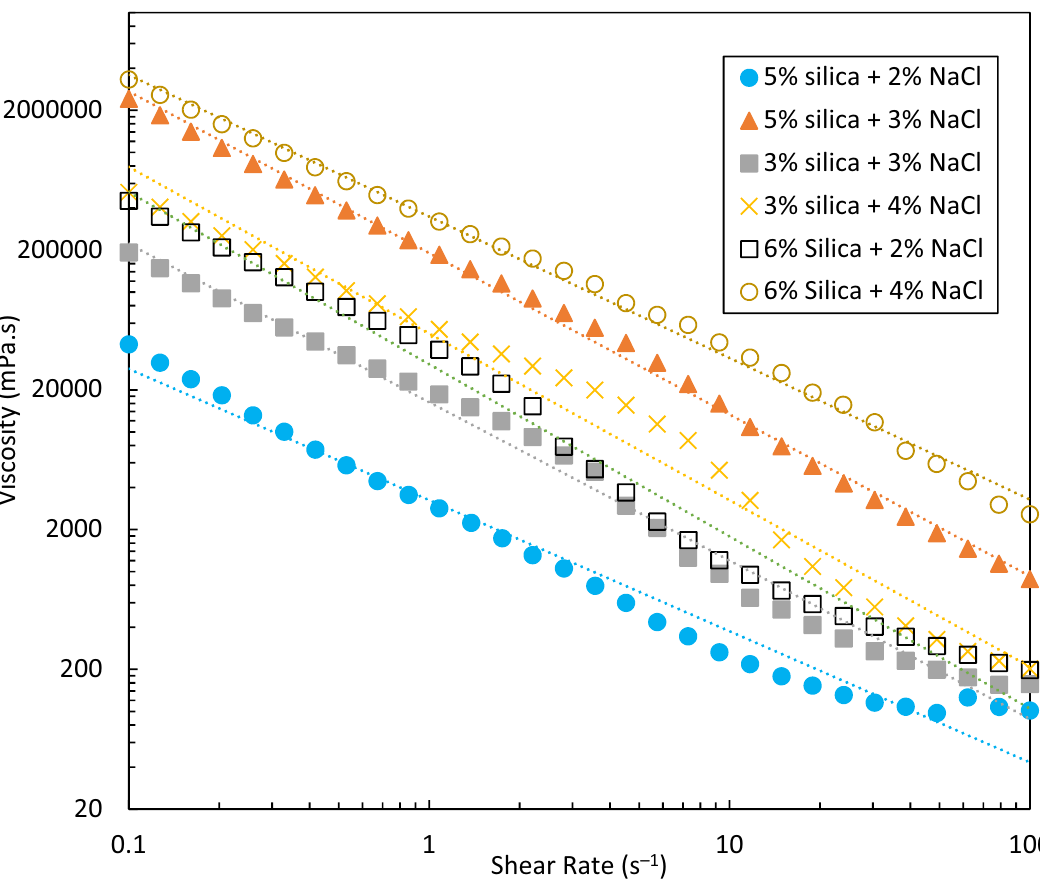
Figure 9. Viscosity versus shear rates for different single-phase solid gels formed by different dispersions at 25 °C. The test was performed after 24 h. The dotted lines show the power law fitted to each set of data